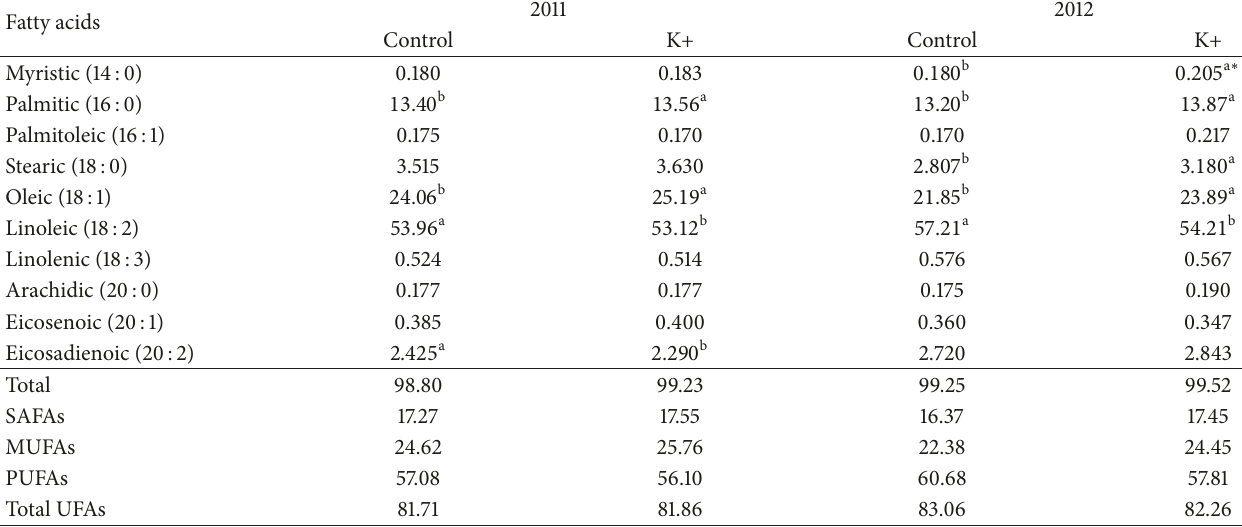
Table 4: Fatty acid composition of black cumin oil extracted from seeds under supplemental K in 2011 and 2012. Fatty acids